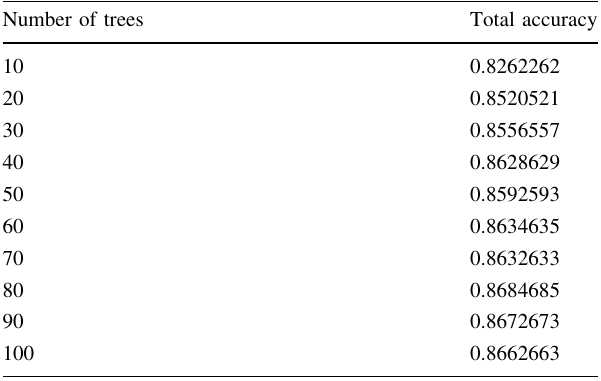
Table 6 Prediction precision of the RF-original models Number of trees